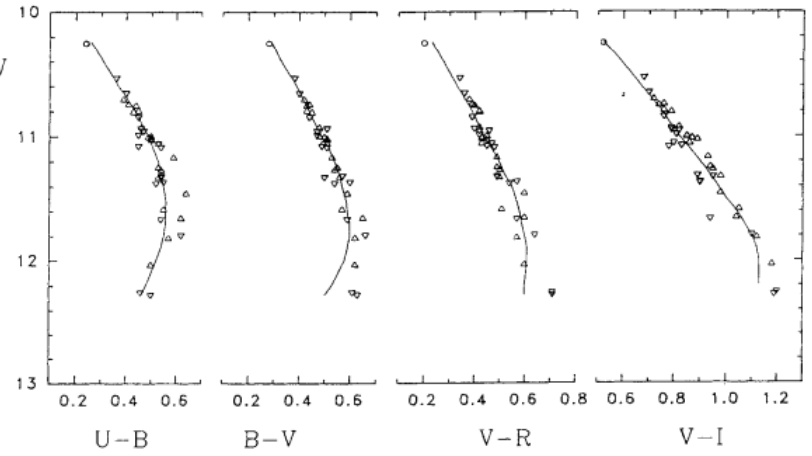
Figure 1. Color–magnitude diagram of the UX Ori type star WW Vul from observations of the deep brightness minimum in 1997 [14]. Open circles mark the ascending part of the minimum; triangles mark its descending part. Lines show theoretical dependencies calculated in [15] on the base of Equation